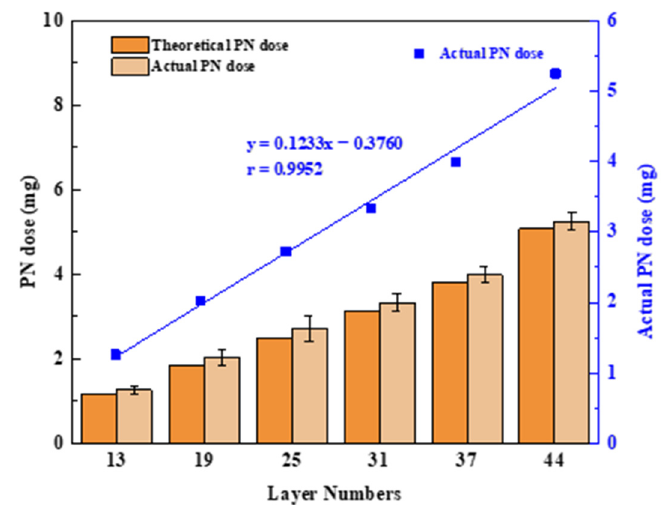
Figure 5. Diagram of the number of printing layers and PN doses; values are expressed as the mean ± SD, n = 3. mean ± SD, n =